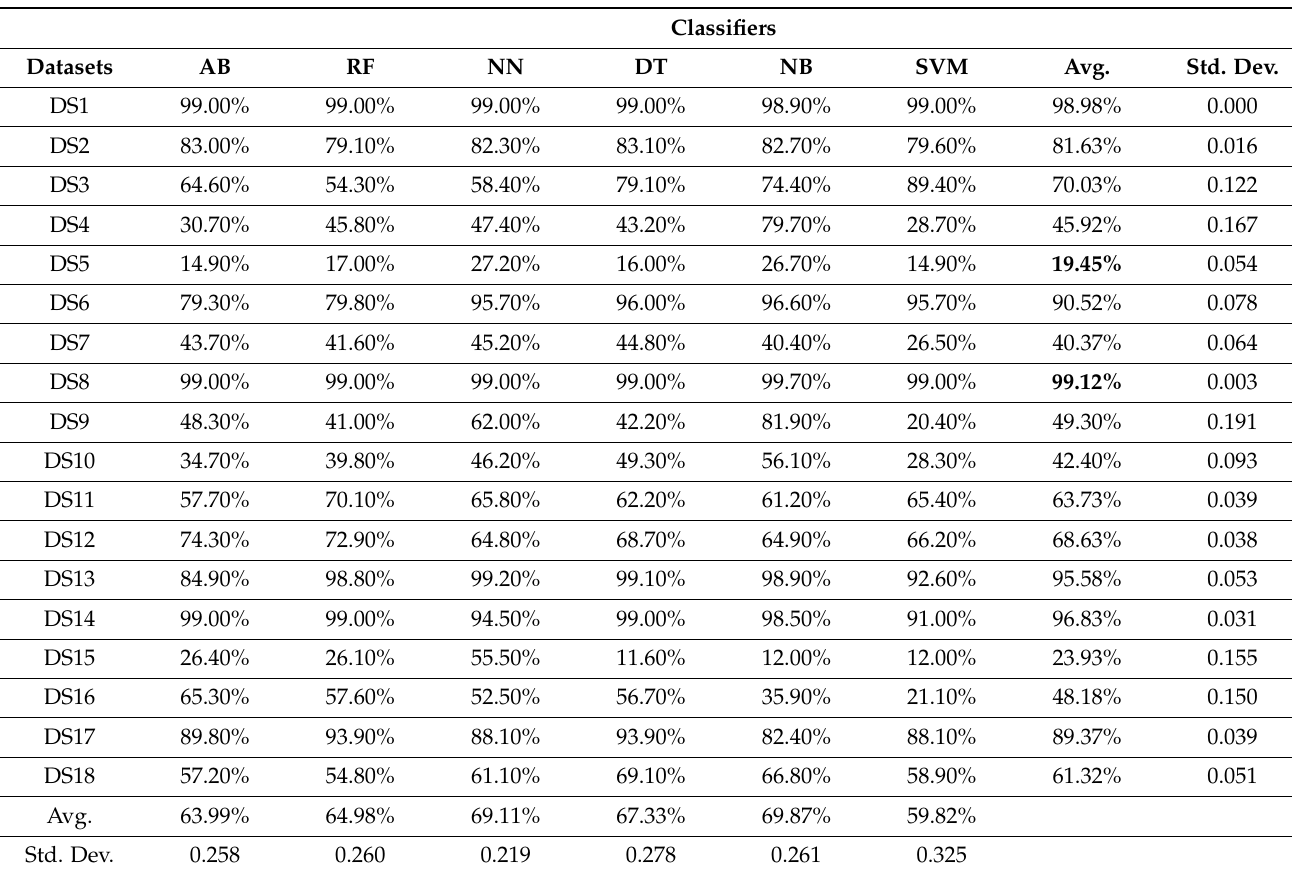
Table A4. Specificity of classifiers trained on small datasets.